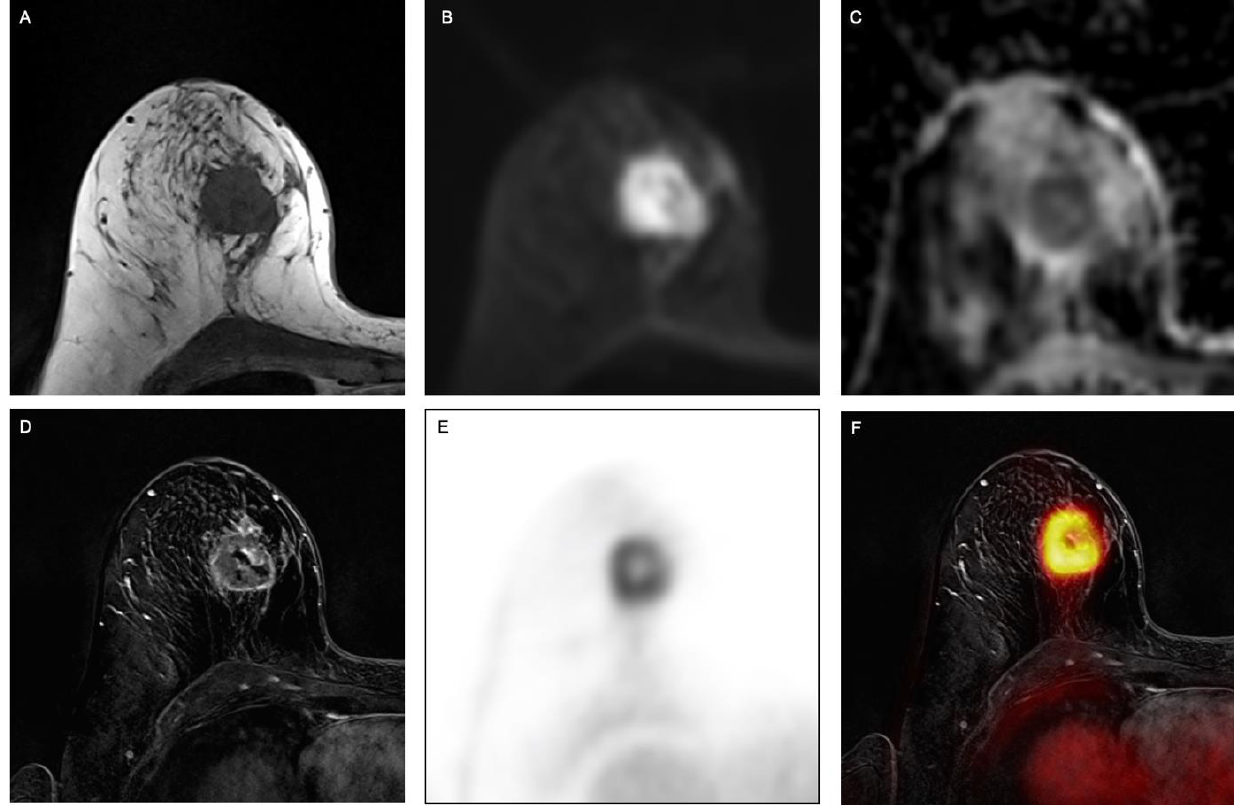
Figure 1. Example of a 63-year-old woman with invasive breast cancer in the right breast, clearly visible on ( A ) fat-saturated T2-weighted turbo spin-echo (TSE) sequence, ( B ) transversal diffusion-weighted echo-planar imaging (EPI) sequence with ( C ) apparent diffusion coefficient (ADC) as well as on ( D ) contrast-enhanced T1w images, ( E ) PET and ( F ) fused PET/MR images.